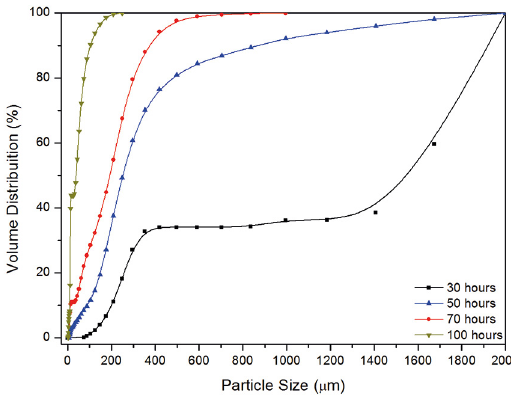
Figure 10. Cumulative particle size distribution.